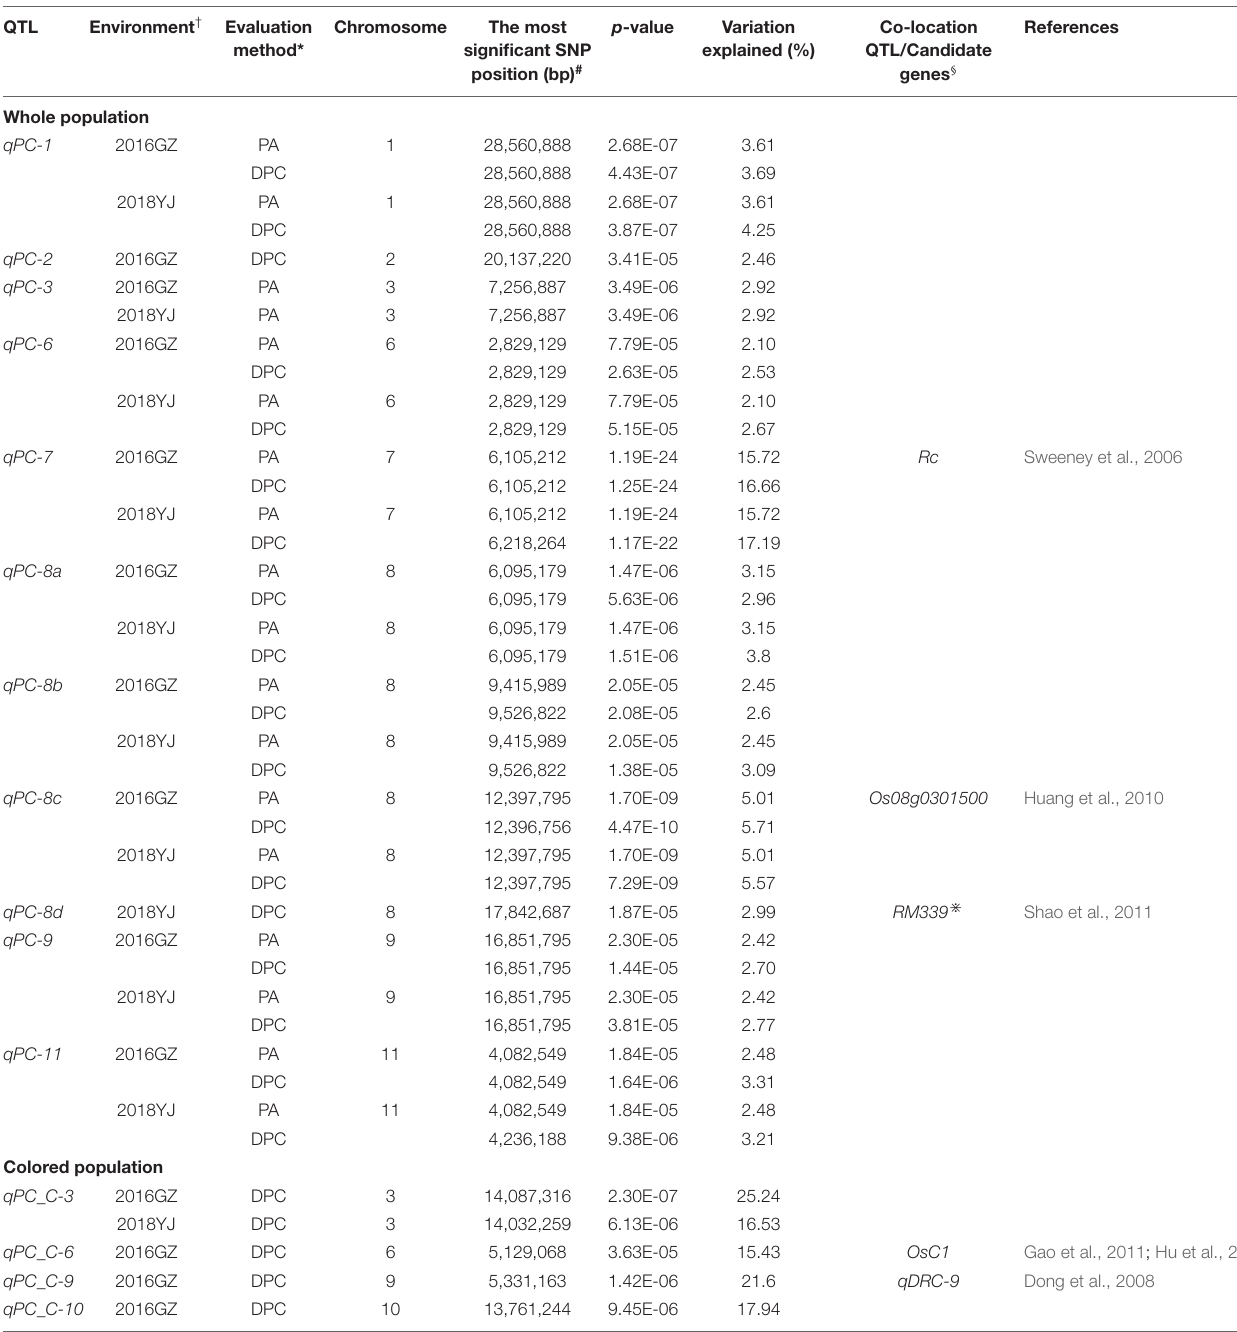
TABLE 1 | QTLs for pericarp color identified in this